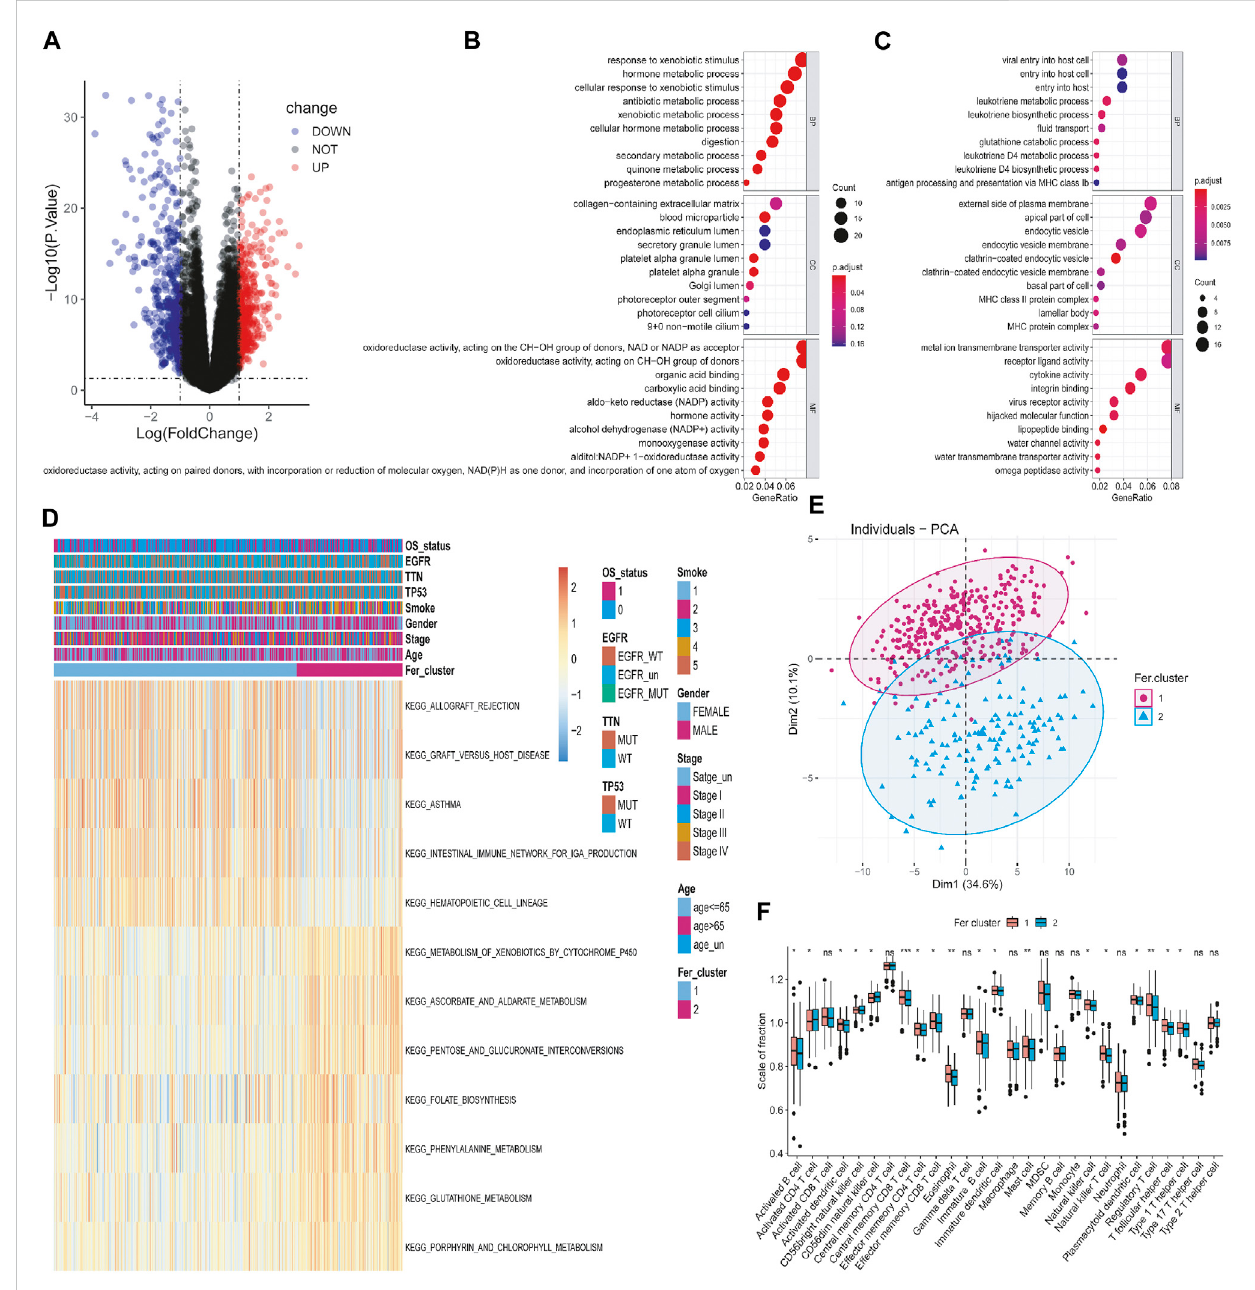
FIGURE 4 Identi fi cation and functional analysis of differentially expressed genes among different tumor ferroptosis subtypes. (A) Volcano map of differential expressed genes. (B,C) Bubble chart of GO enrichment analysis of upregulated and downregulated genes. (D) KEGG enrichment analysis of gene set. (E) PCA analysis of expression pro fi le. (F) Tumor immune cell in fi ltration analysis of the gene